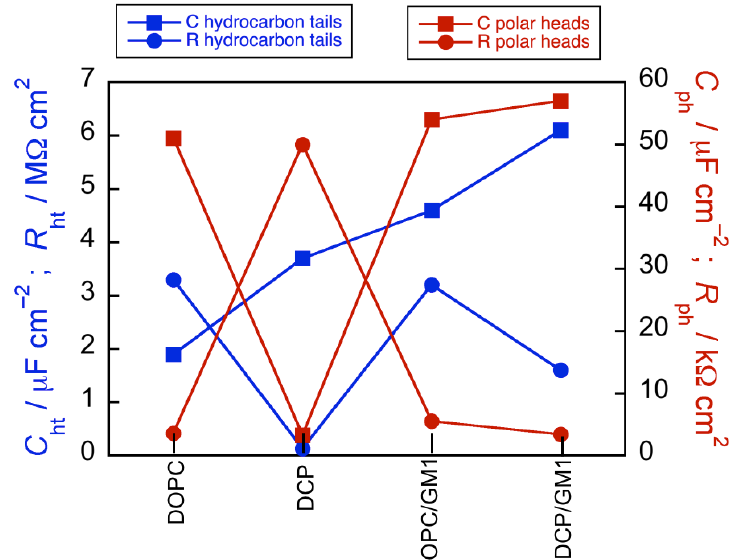
Figure 5. Capacitance and resistance of hydrocarbon tails and polar heads along the DOPC, DCP, DOPC/GM1, DCP/GM1